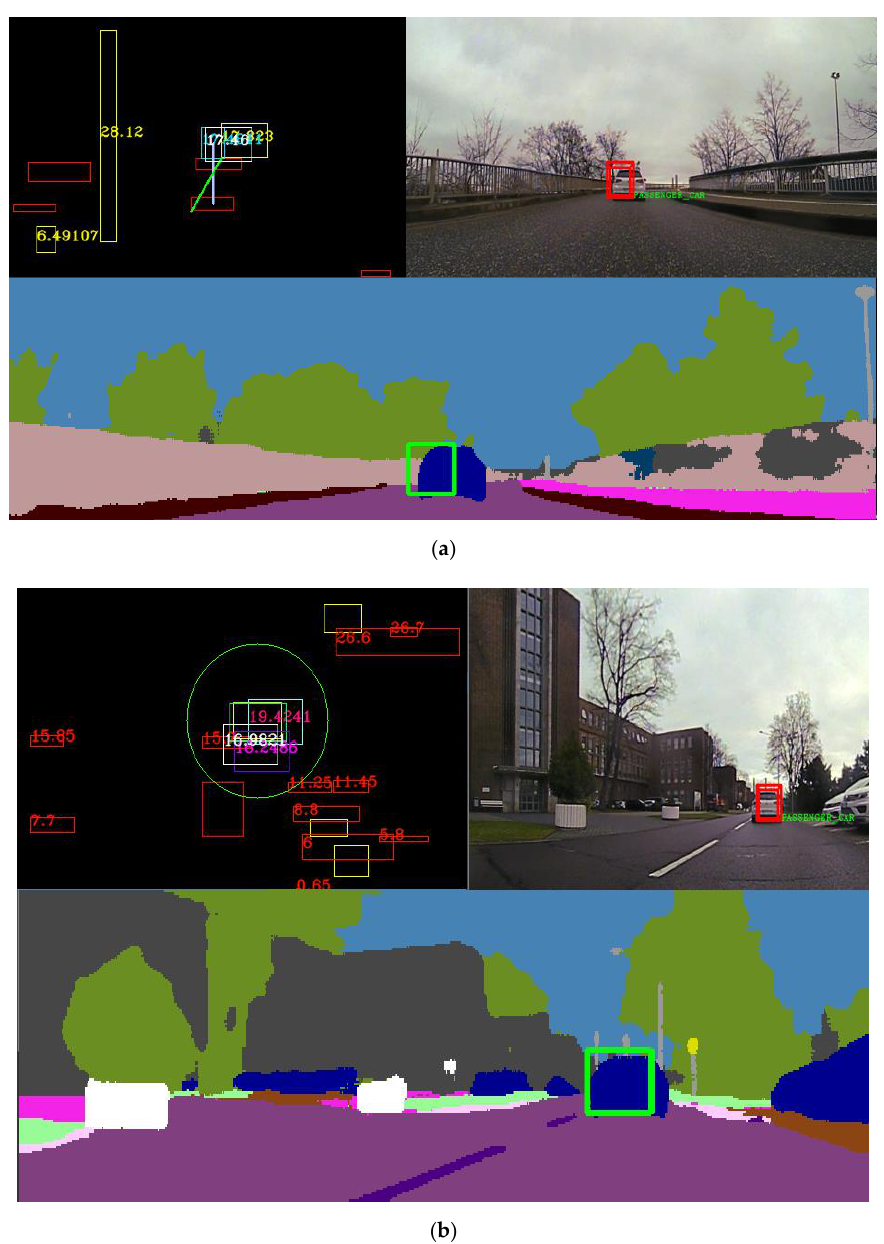
Figure 23. ( a ) In the top left picture, we illustrate the birds-eye view virtual image of the scene, where all objects are projected. In the top-right figure, we show the RGB image and the validated and stabilized super-sensor object projected on it. In the bottom image, the semantic segmentation image is depicted, and the validated super-sensor object is displayed with a green rectangle. In this scenario, only the UKF fusion was enabled. ( b ) The presented algorithm is depicted running in a heavy clutter scenario. The top-left figure is the birds-eye view virtual image. The top-right figure is the RGB image with the validated super-sensor object projected onto it. The bottom image displays the validated fused object projected onto the semantic segmentation image. In this scenario, both the UKF and neural fusion methods were enabled.